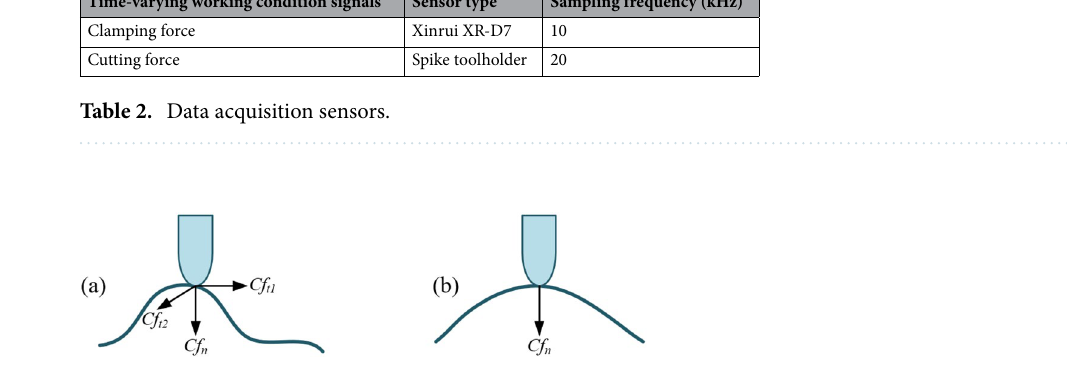
Figure 8. Common forms of part-fixture contact ( a ) normal clamping force—bidirectional friction contact and ( b ) normal clamping force contact.